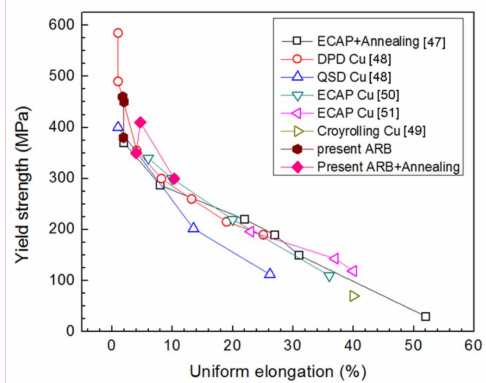
Figure 10. Yield strength versus uniform elongation of bimodal Cu prepared by dynamic plastic deformation (DPD), quasi-static deformation (QSD) [48], cryorolling [49], ECAP [47,50,51], ARB, and subsequent